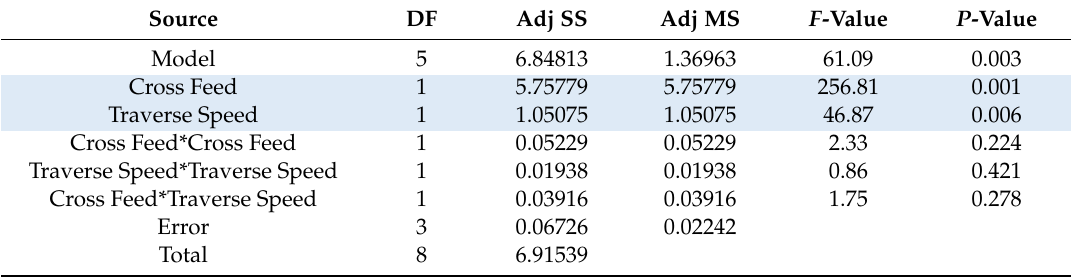
Table 7. ANOVA analysis of the free surface energy obtained in abrasive water jet texturing. Source